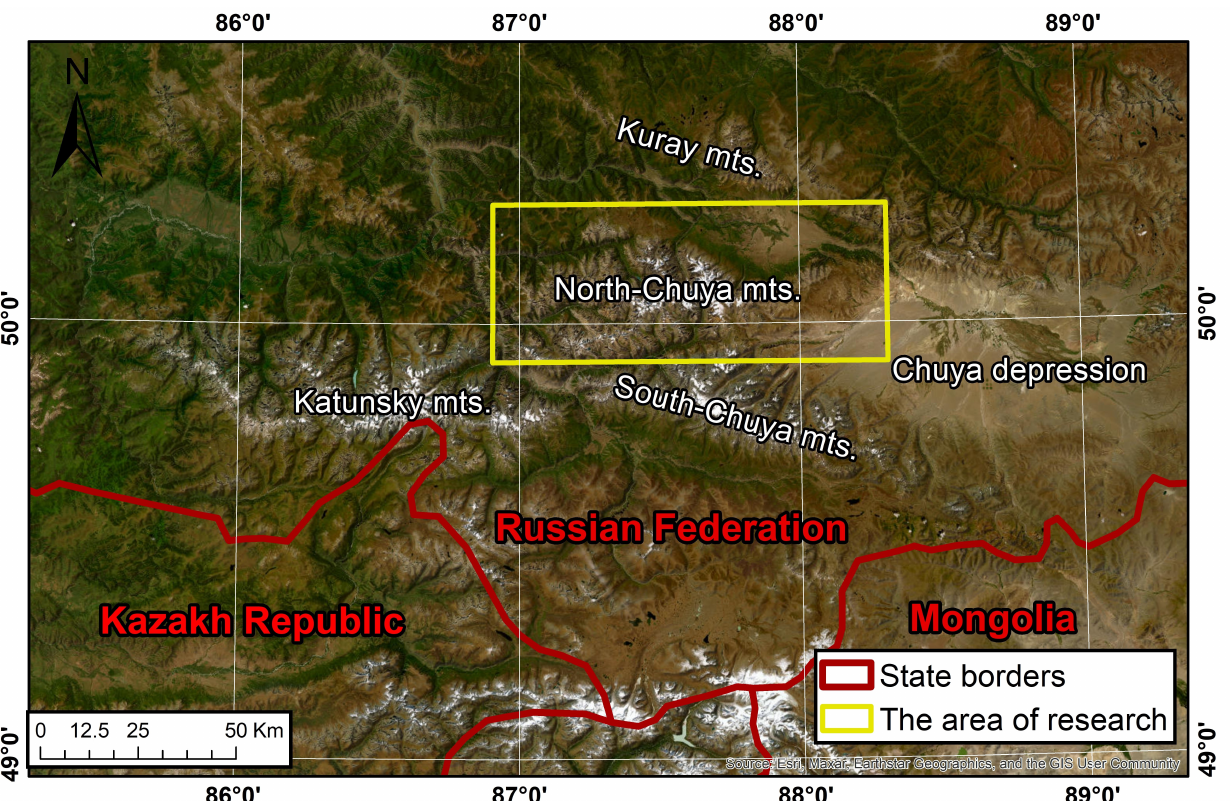
Figure 1. The area of research. The background of the image is presented by Arcgis World Imagery. The North-Chuya ridge stretches about 100 km in the east-west direction. The ridge reaches its greatest height in the central part, known as the Bish-Iirdu mountain junction, in which the main glaciation of the ridge is concentrated. The average altitude of the